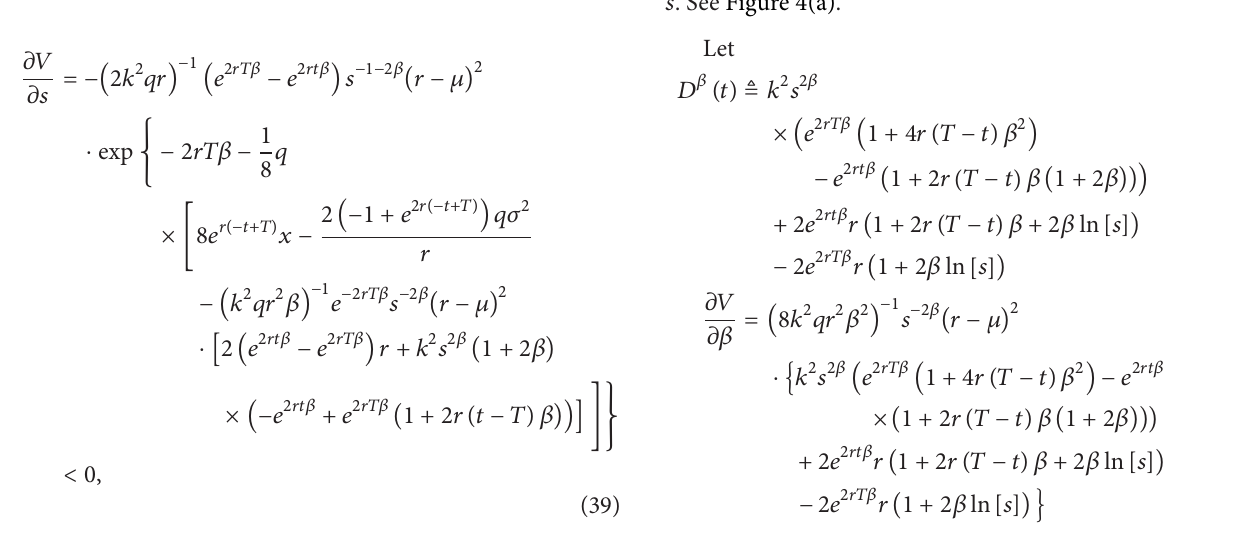
Completely similar to the analysis in (1), we also